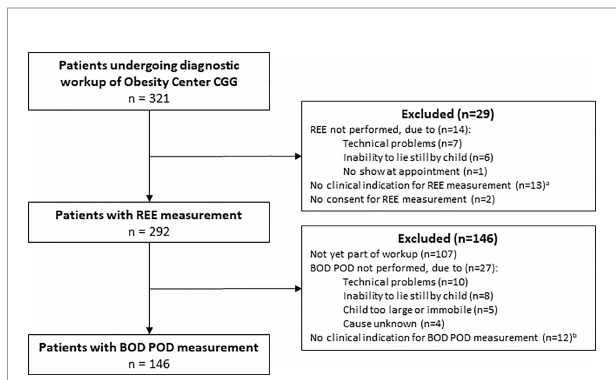
FIGURE 1 | Study fl ow diagram. CGG, ‘ Centrum Gezond Gewicht ’ (in English: ‘ Center for Healthy Weight ’ ); REE, resting energy expenditure. a Examples of no clinical indication for REE measurement were: REE already performed elsewhere or patient being too young for reliable measurement; b Examples of no clinical indication for BOD POD measurement were: body composition already measured using dual energy X-ray absorptiometry or patient not suitable for reliable measurement e.g. due to severe intellectual